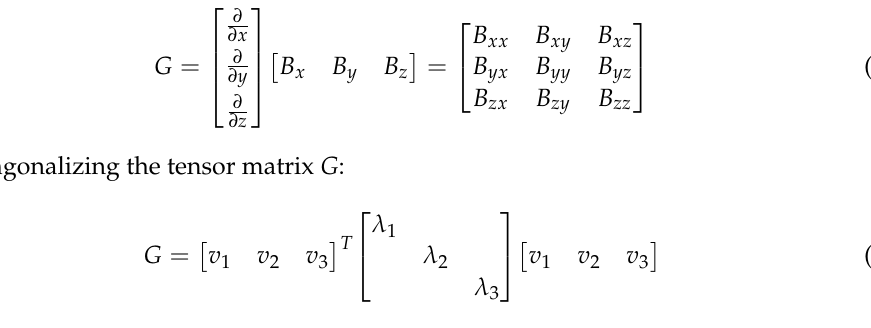
 ,  , and  are the eigenvalues and where 1 2 3 ing eigenvectors. This means that at any measurement point it is possible to find a Carte- sian system in which the gradient tensor has zero off-diagonal terms. Therefore, under any coordinate transformation, the tensor matrix has three quantities that are not trans- formed with the coordinates [20]: